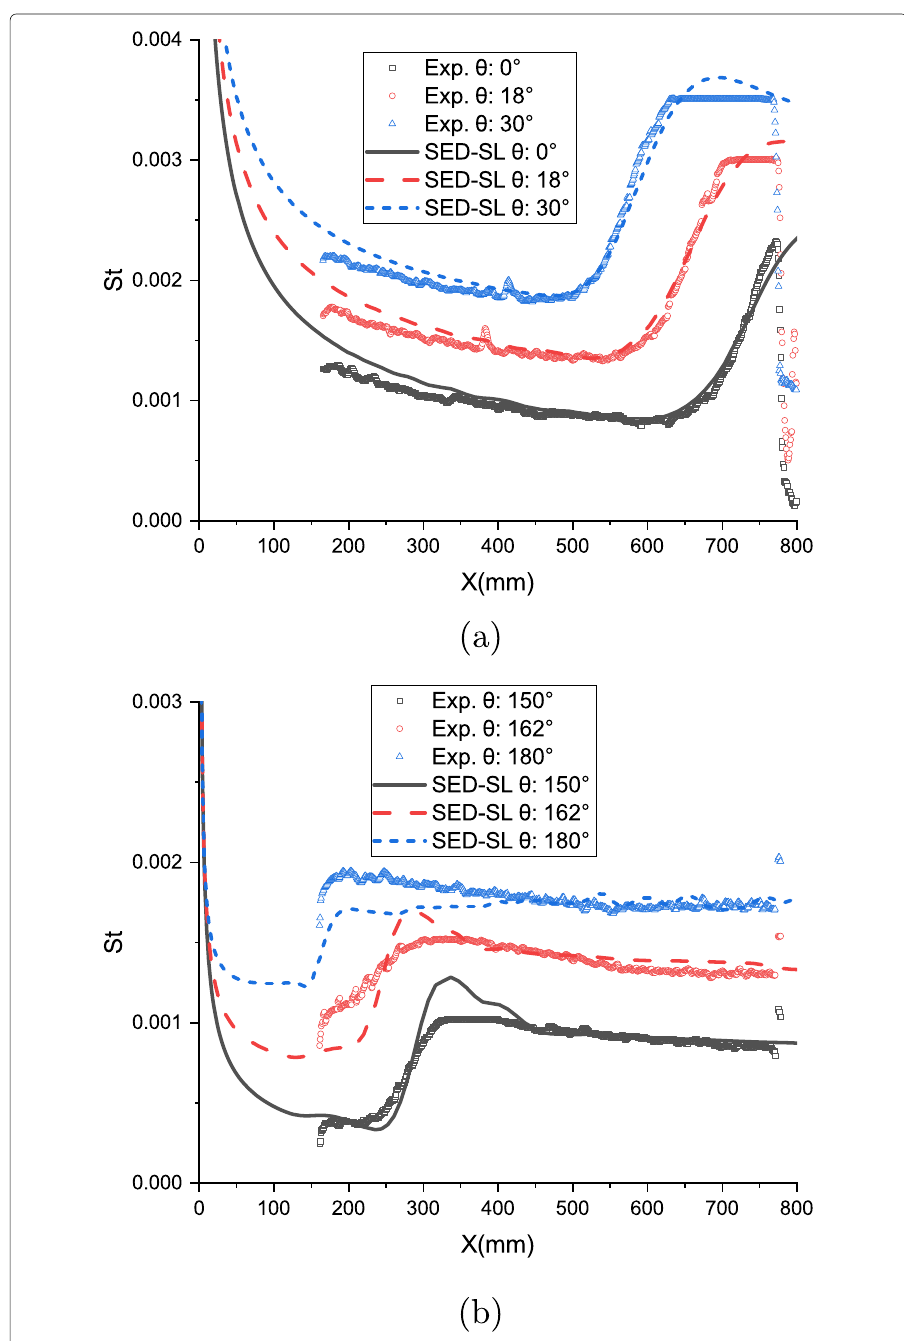
Fig. 12 Comparisons between the rescaled surface temperature increment distributions measured in experiment and the St distributions computed by the SED-SL model for the CARDC-6 case. a The windward surface, b the leeward surface. The data are vertically translated to be clearly